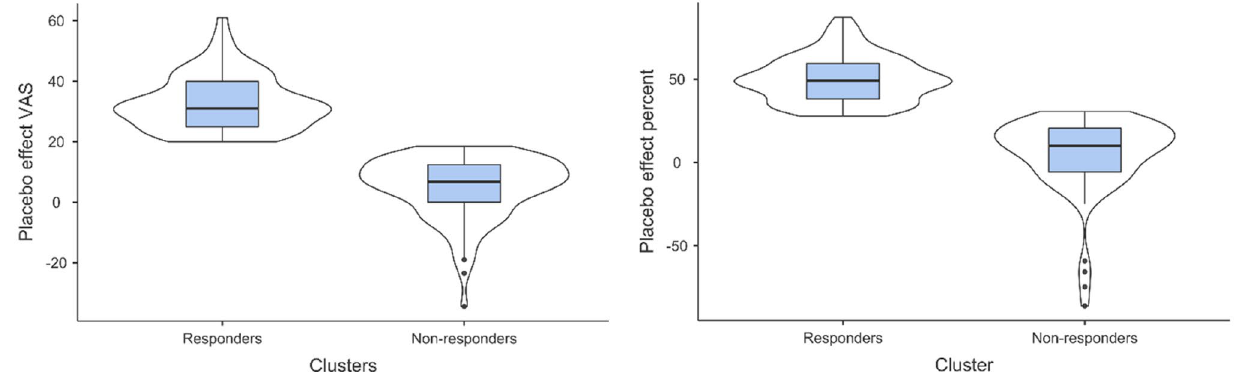
Figure 1. Box and violin plots showing the density of placebo responders versus